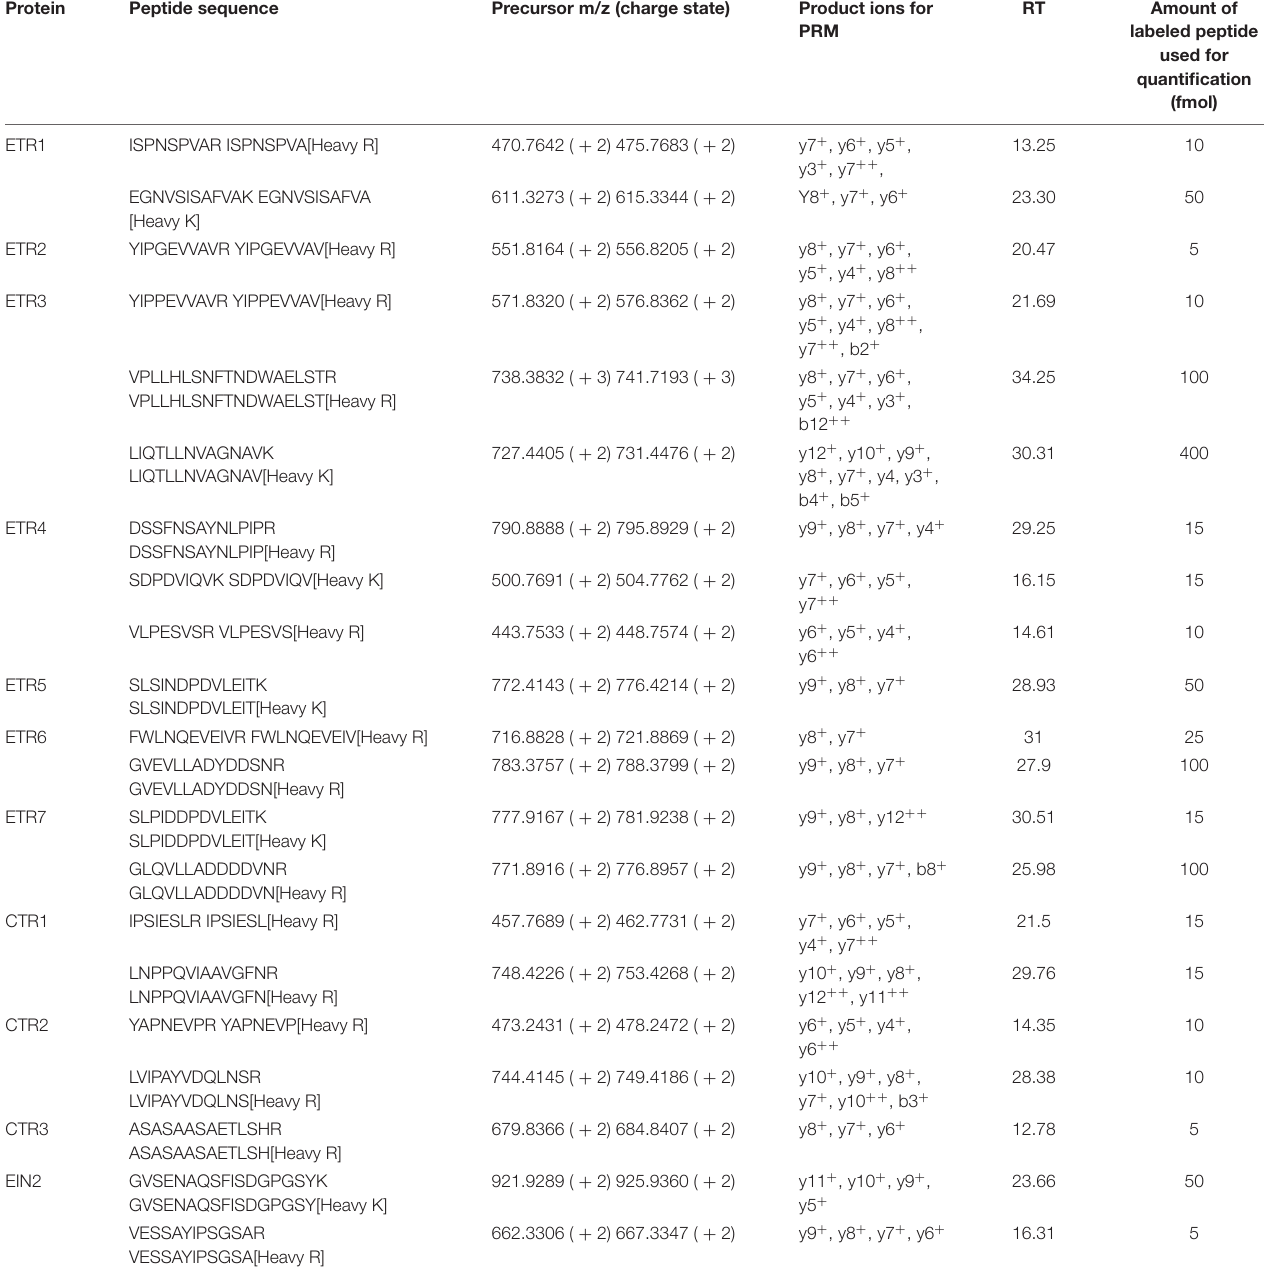
TABLE 1 | List of the proteins identified and quantified, their peptides and their corresponding labeled peptides monitored in PRM analysis, the precursor’s m/z and charge, the product ions used for the quantification, the average retention time (RT) of their extracted ion peaks and the amount of labeled peptide in fmol used to spike into the samples for the quantification of the endogenous